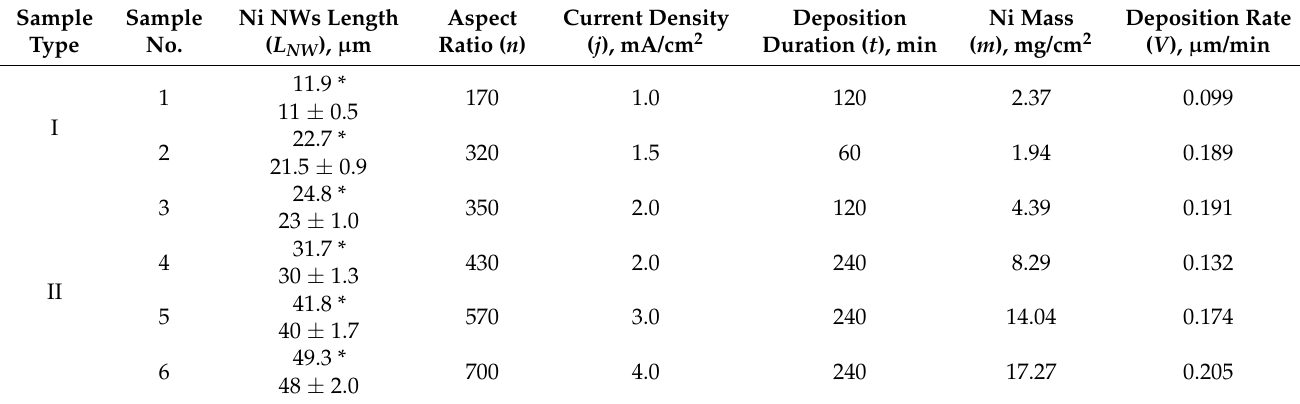
Table 2. The main technological parameters of the preparation process of the Ni NWs in MPAA.